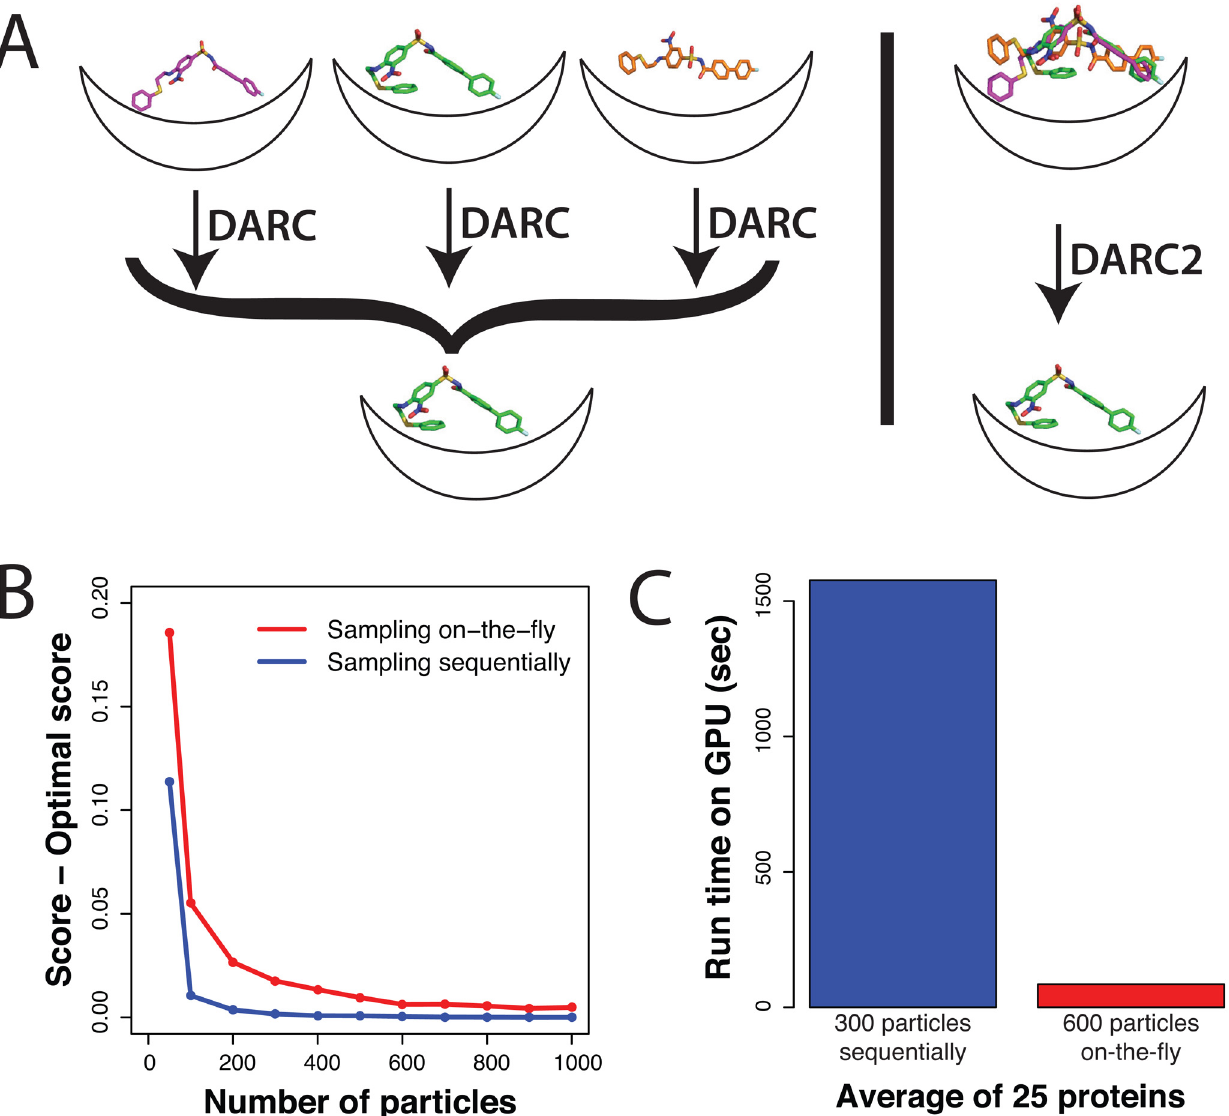
Fig 4. Screening ligand conformers “ on-the-fly ” during docking. (A) Previously, ligand conformations were docked sequentially through separate docking trajectories, and the ligand conformation was ultimately drawn from the best-scoring complex. In DARC 2.0, we instead sample ligand conformers during the docking trajectory. (B) Due to the extra degree of freedom associated with a single docking trajectory, docking converges more slowly when conformers are sampled “ on-the-fly ” . Here, convergence is evaluated by the score difference relative to a “ gold standard ” (best achievable score) for each complex; the results shown are averaged over the 25 complexes in our test set (S1 Table). For each point in this plot, the number of particles in PSO optimization and the number of steps in the docking trajectory were set equal to one another. (C) Despite the fact that individual trajectories converge more slowly when conformers are sampled “ on-the-fly ” , docking is comprised of only a single trajectory. Across our set of 25 complexes, this ultimately makes “ on- the-fly ” sampling an average of 18-fold faster than sampling conformers sequentially through multiple docking